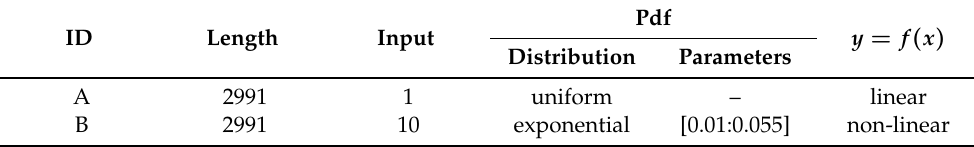
Table 4. Characteristics of “truth” datasets with expression between input and output, linear: